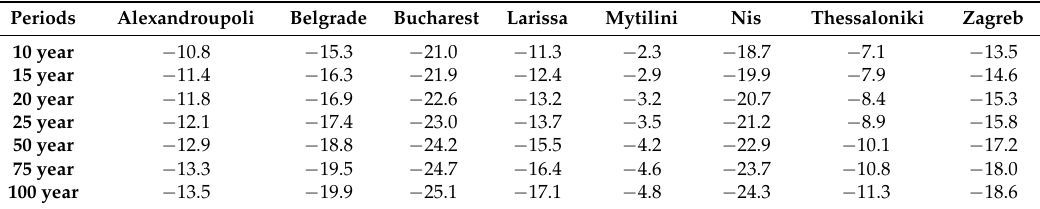
Table 4. Return levels for different return periods.